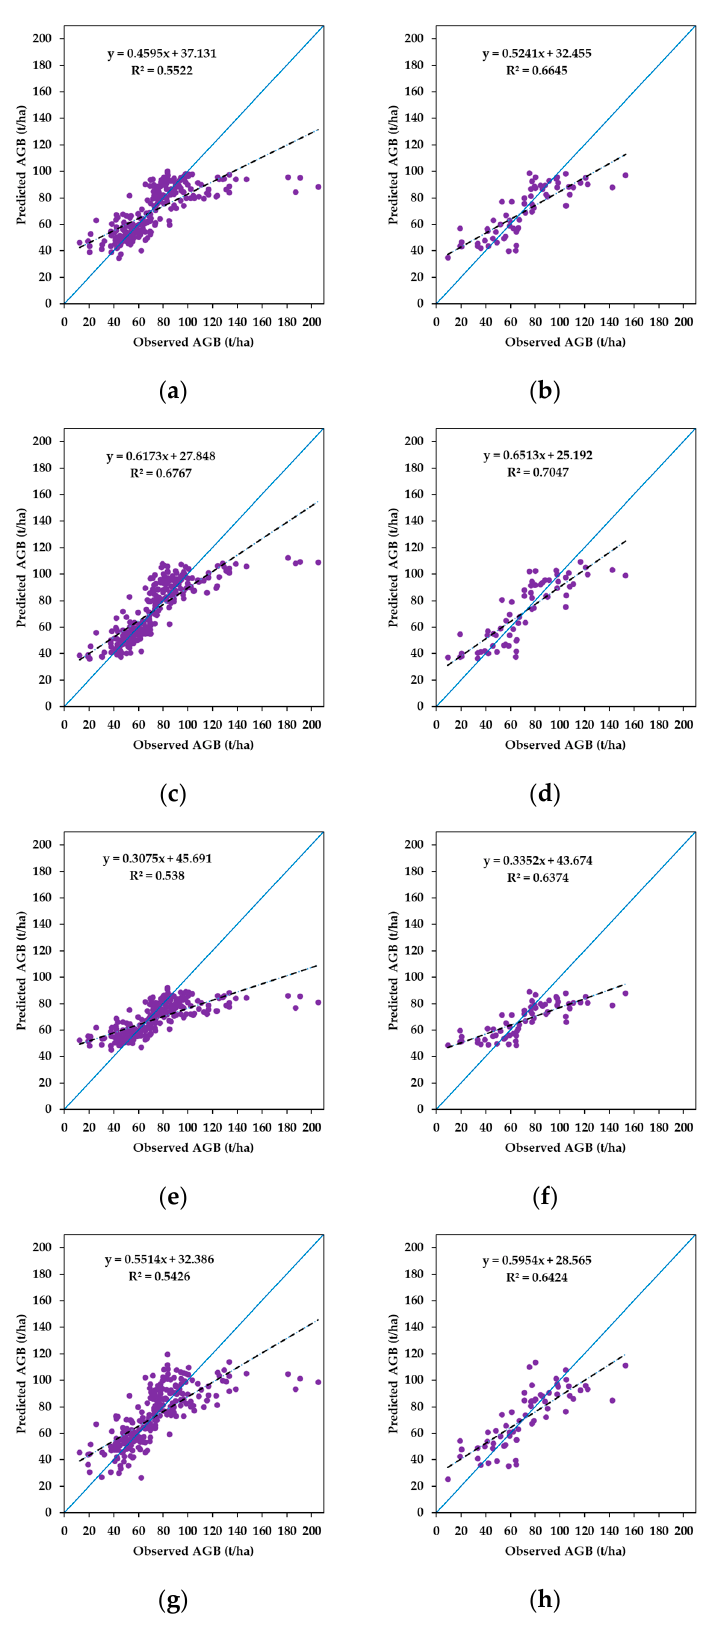
Figure 3. Scatter plots of the four models in estimating AGB in the training datasets ( left ) and testing datasets ( right ): ( a , b ) SVM, ( c , d ) RF, ( e , f ) BPNN, and ( g , h ) SMR.